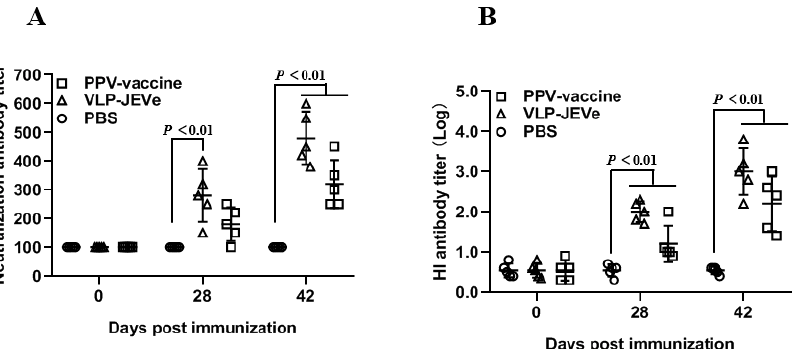
Figure 5. VLP-JEVe specific humoral immune response in guinea pigs. Three groups of guinea pigs were vaccinated with VLP-JEVe, PPV inactivated vaccine, and PBS as control. The blood samples were collected at the indicated time-points for virus neutralizing antibody ( A ) and hemagglutination inhibition assays ( B ). Titers are represented as mean ± SEM and the p < 0.01 indicates the statistical difference between vaccinated and PBS